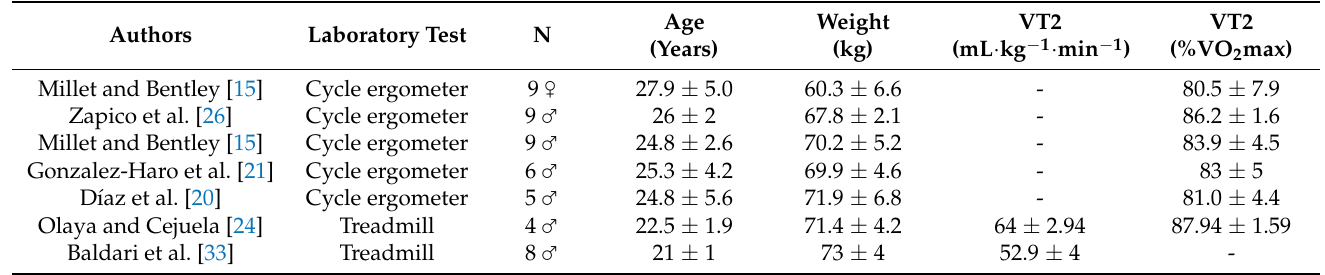
Table 4. Mean ± SD values of VO 2 at VT2 of elite triathletes.